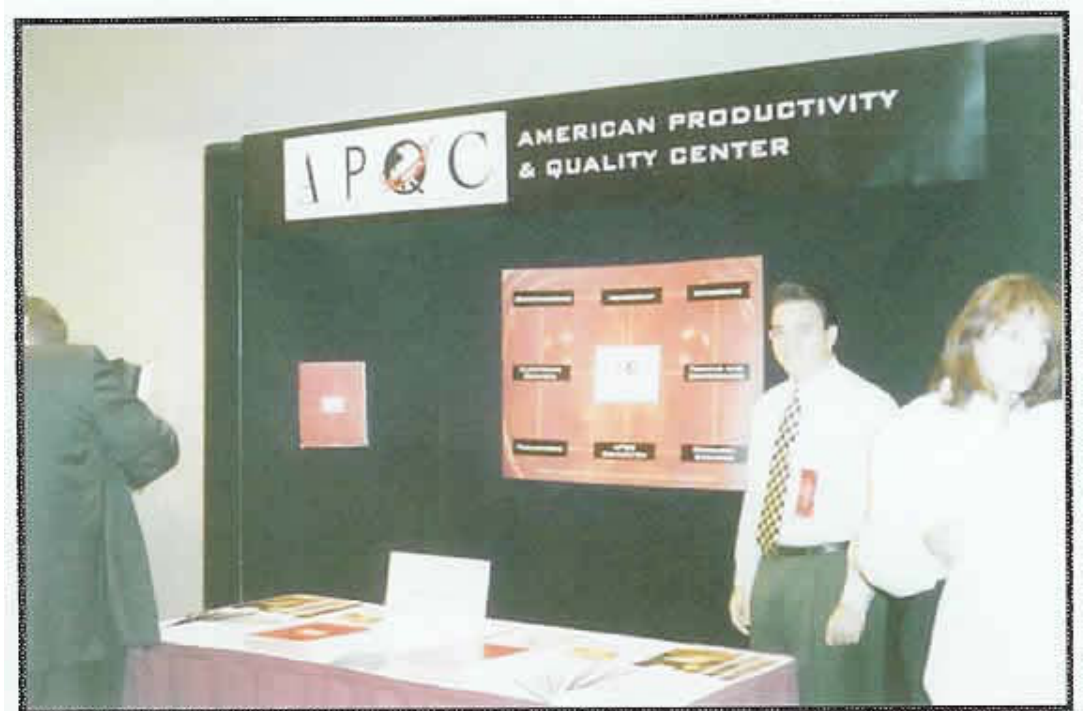
Figure 9 TManage (picture courtesy of ITAC